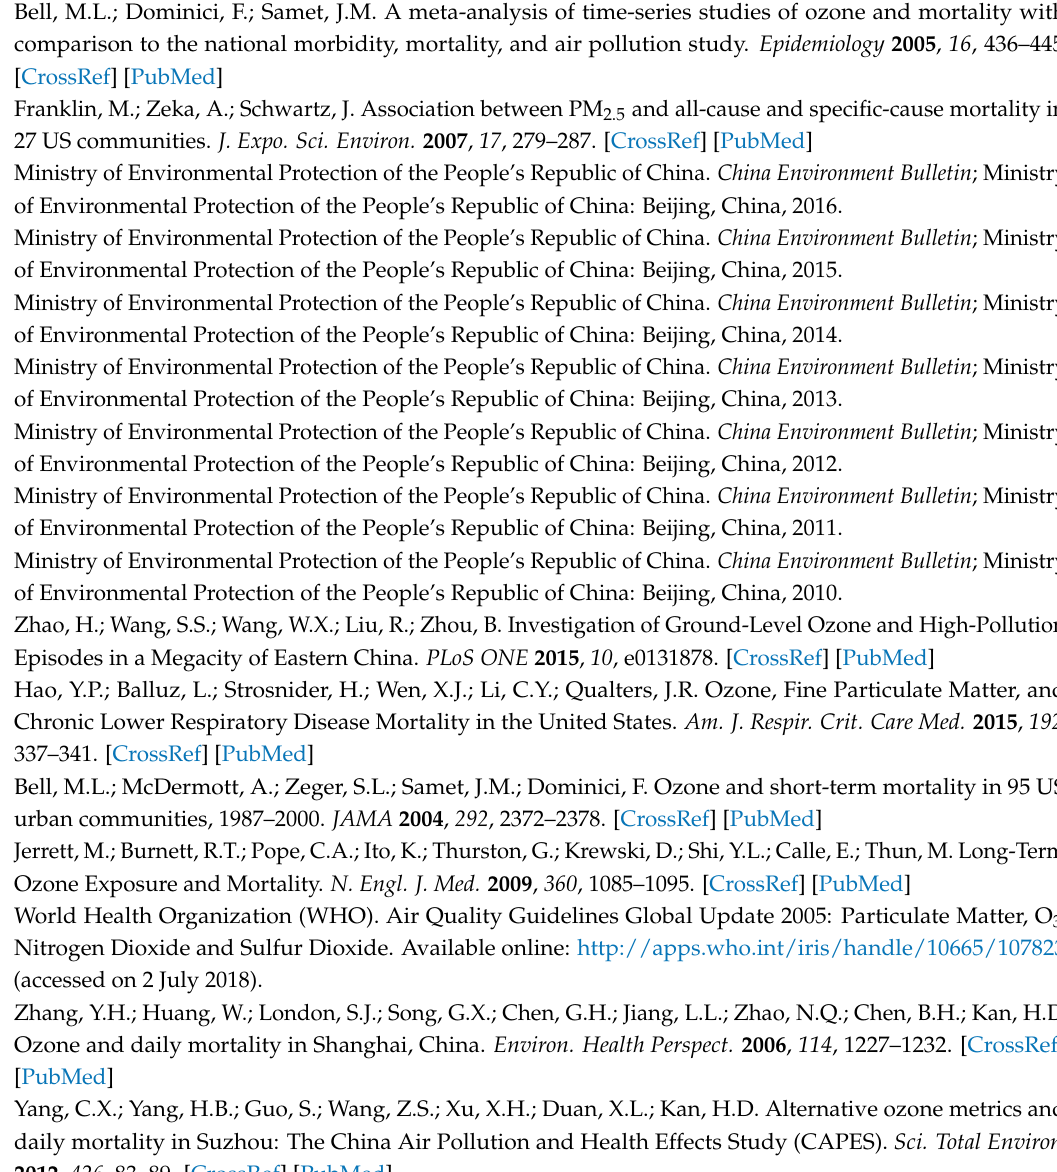
Figure S1: Smoothed plots of relative risk against ozone